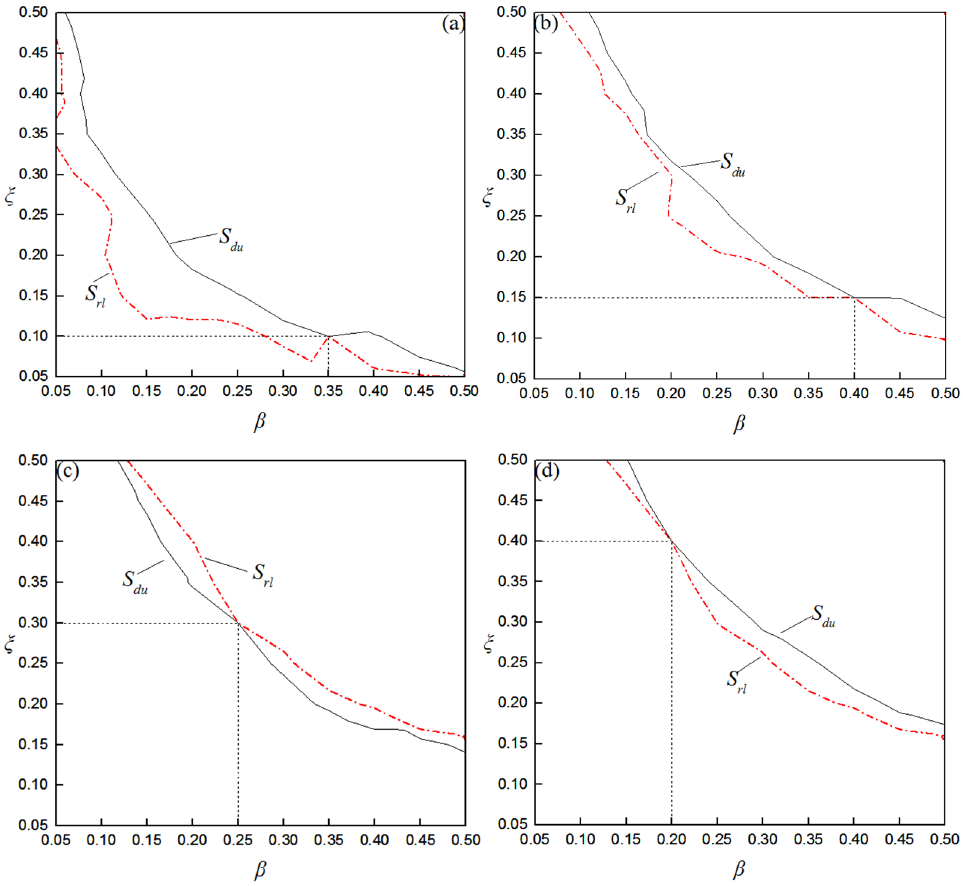
Figure 10. Crack parameter identification for a single-period response; ( a ) β = 0.35, ξ = 0.1; ( b ) β = 0.4, ξ = 0.15; ( c ) β = 0.25, ξ = 0.3; ( d ) β = 0.2, ξ = 0.4.